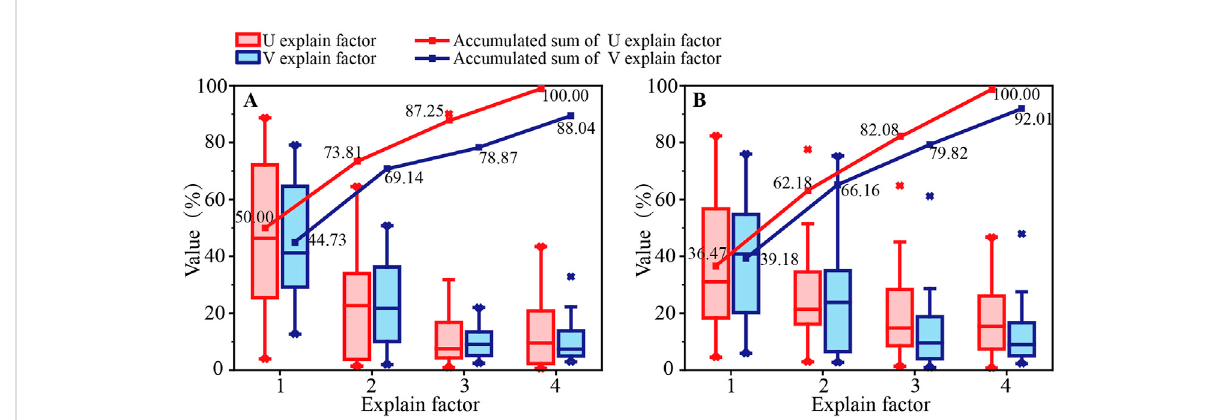
FIGURE 5 BoxplotsoftheexplanatoryfactorsfortypicalvariablesderivedforHincidenceandPincidence. (A) panelshowstheboxplotoftheexplanatory factor for the case of H incidence, and (B) panel shows the case of P